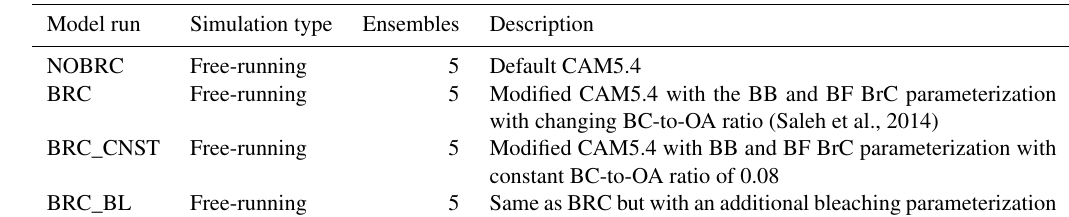
Table 1. Description of the model simulations used in this study.